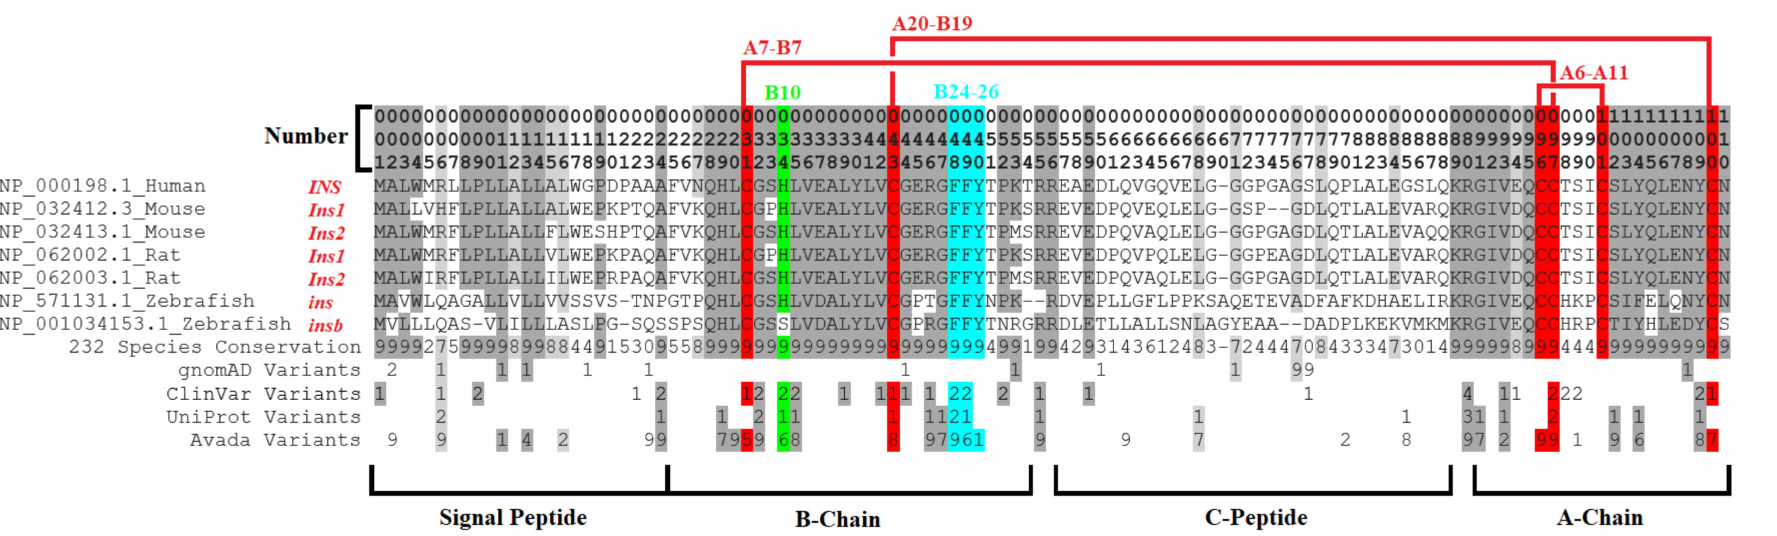
Figure 9. Compiled insulin alignment data including duplication copies of mouse, rat, and zebrafish. The numbers listed at the top can be read as the first digit representing the hundreds place, followed by the tens, and the last number as the single digit. For conservation and all listed human variants, a value of nine is the highest, representing anything ≥ 9. The conservation is shown as the percent of 232 vertebrate species, where 9 = 100–90% conserved, 9 = 80–90%, and so on. Conserved sites at 7 or higher are gray, with those 9 in darker gray. Red are disulfide bonds, cyan is the dimer region, and green is the hexamer